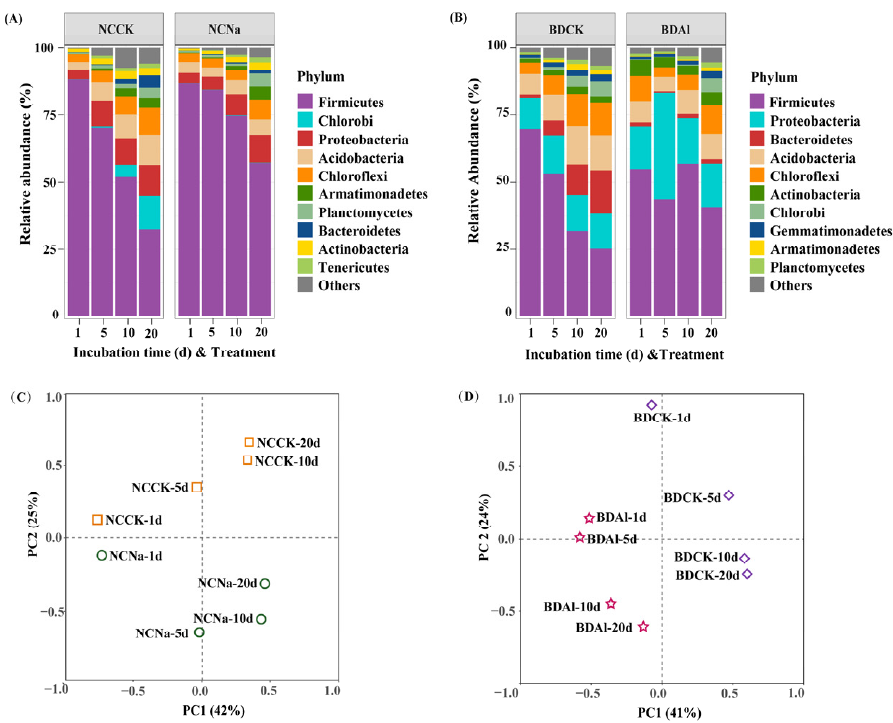
Figure 2. Relative abundance of dominant bacterial phyla ( A , B ) and principal component analysis plot ( C , D ) based on the UniFrac distances using the relative abundances of OTUs in paddy soils with acidification or alkalization.